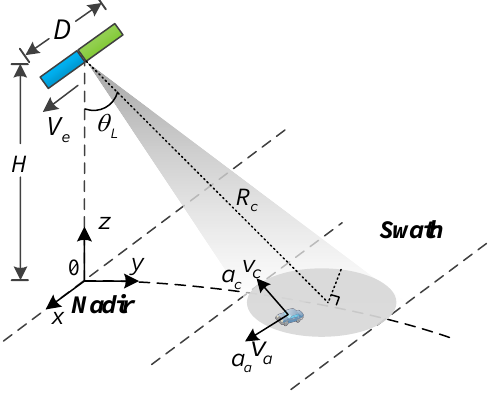
Figure 2. Geometry of the Gaofen-3 SAR sensor with dual receive channel mode.